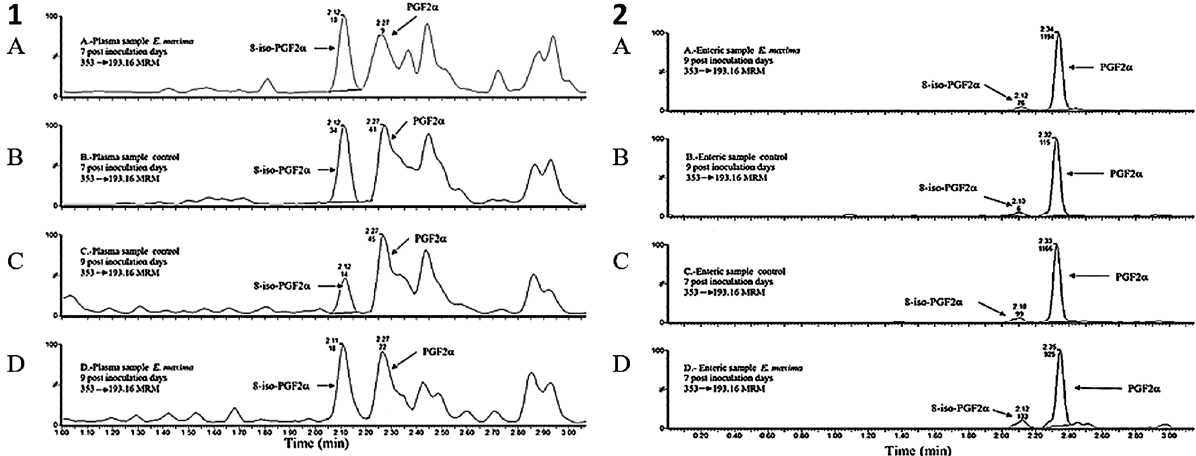
Figure 1. Chromatograms of 8-iso-PGF2α and PGF2α. ( 1 ) Obtained from plasma samples: A—sample of E. maxima 7 days post-inoculation chickens, B—sample of control of 7 days post-inoculation chickens, C—sample of control of 9 days post-inoculation chickens, and D—sample of E. maxima 9 days post-inoculation chickens. ( 2 ) Obtained from enteric (jejunum) samples: A—sample of E. maxima 9 days post-inoculation chickens, B— sample of control of 9 days post-inoculation chickens, C—sample of control of 7 days post-inoculation chickens, and D—sample of E. maxima 7 days post-inoculation chickens.